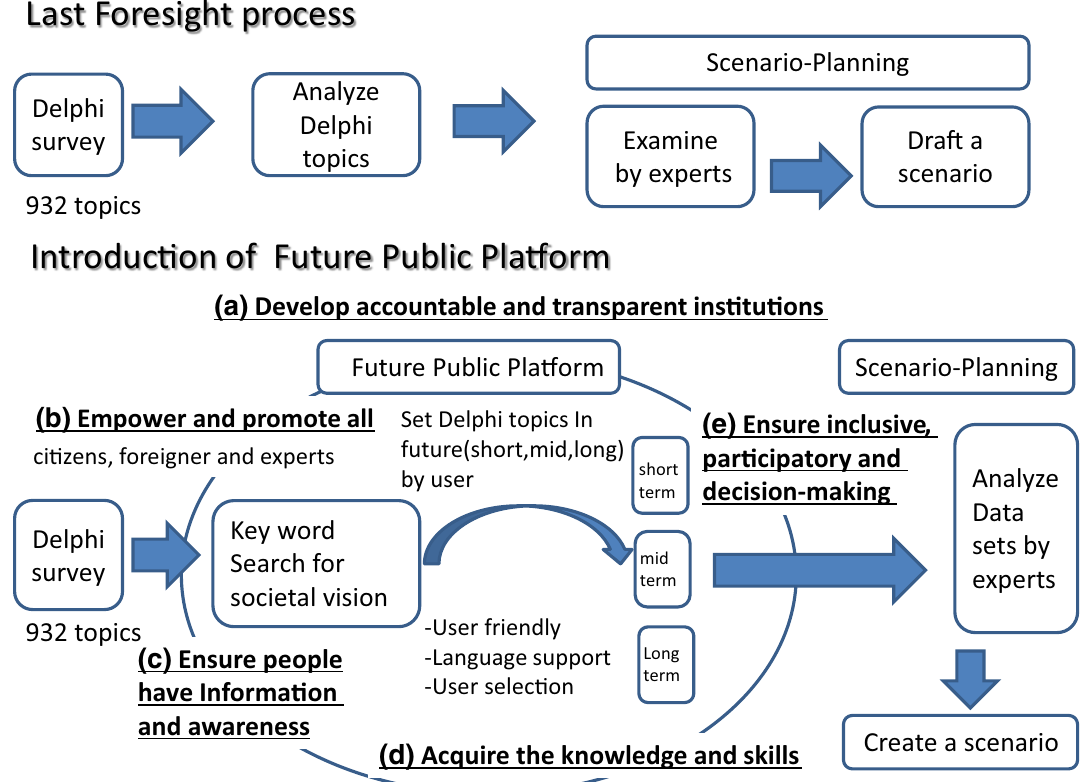
Fig. 7 The Future Public Platform and scenario